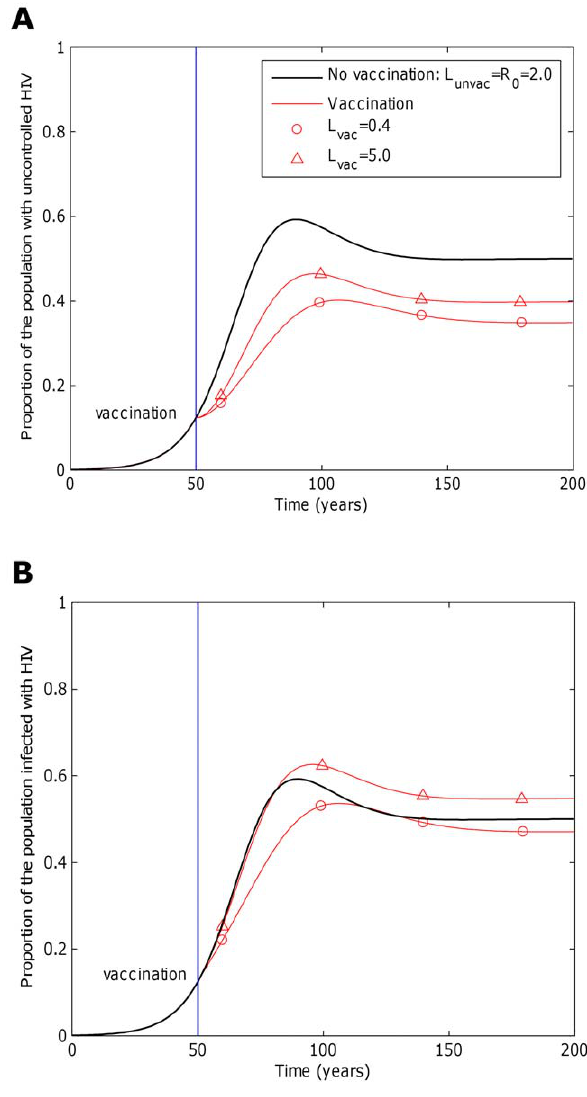
Figure 2. The impact of a CTL-based vaccine is dependent upon the extent to which it affects transmission potential. This figure considers the impact that a five-epitope vaccine could have on an epidemic. Two measurements are considered: A) the proportion of hosts in the population with uncontrolled infections and B) the proportion of hosts who are infected. In each panel two vaccines with different average transmission potentials are explored and compared to the scenario when the vaccine is absent (black line). Our simulations are based upon an epidemic in a sub-saharan community, thus we assume a basic reproductive number of 2 in the absence of